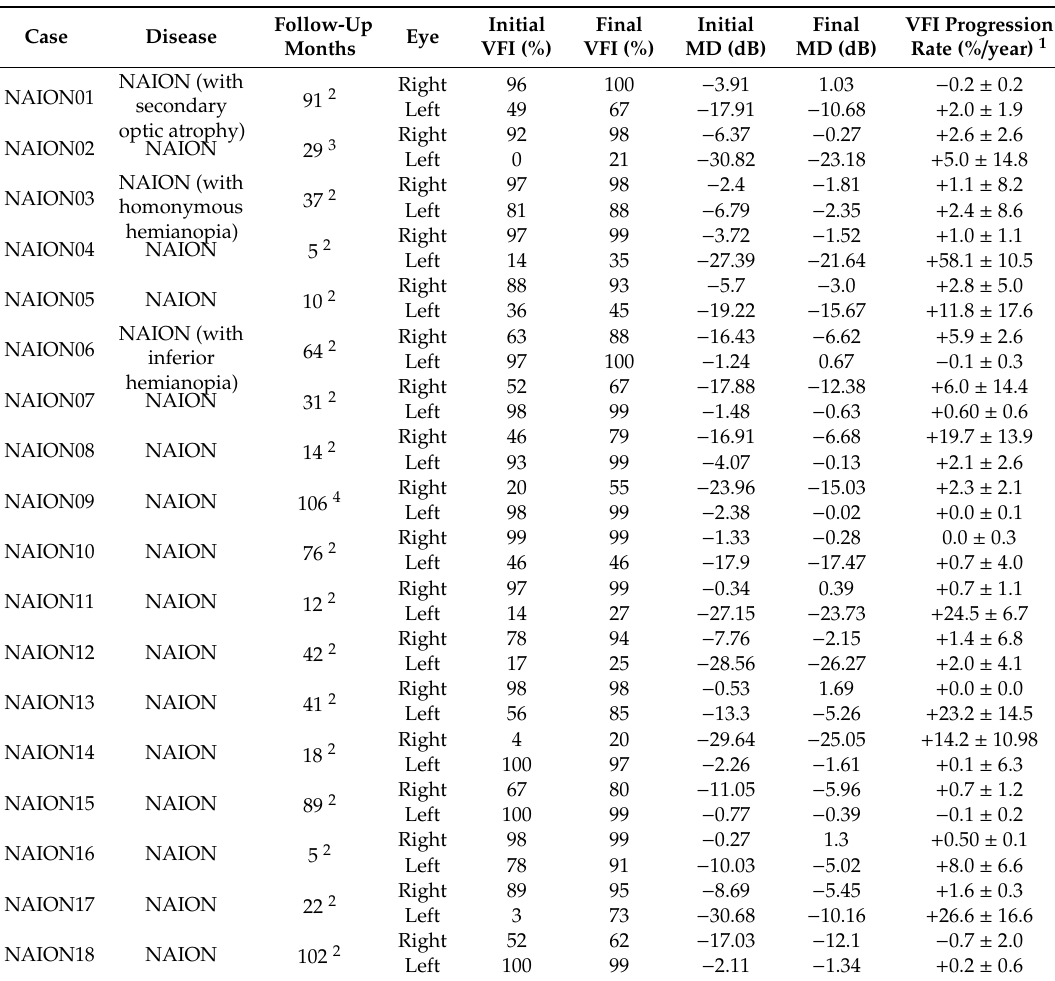
Table 2. Clinical characteristics of NAION cases, VFI and MD follow-up, and progression